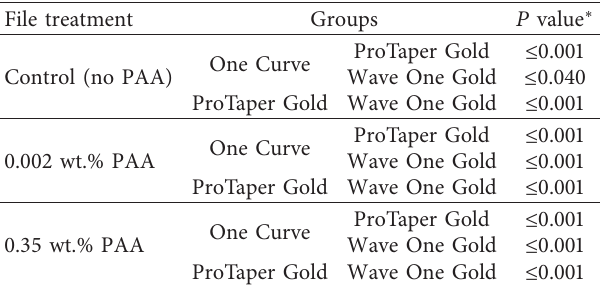
Table 3: P values of multiple comparisons by ANOVA/Bonferroni test for NCF before and after immersion in 0.002% or 0.35% PAA.